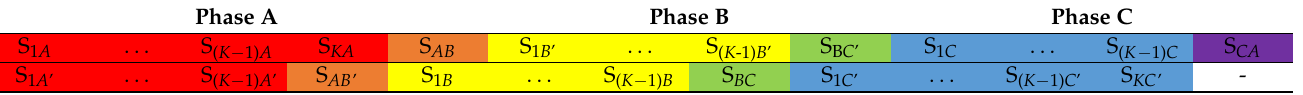
Table 5. Slot distribution to phases of UOSW type A .